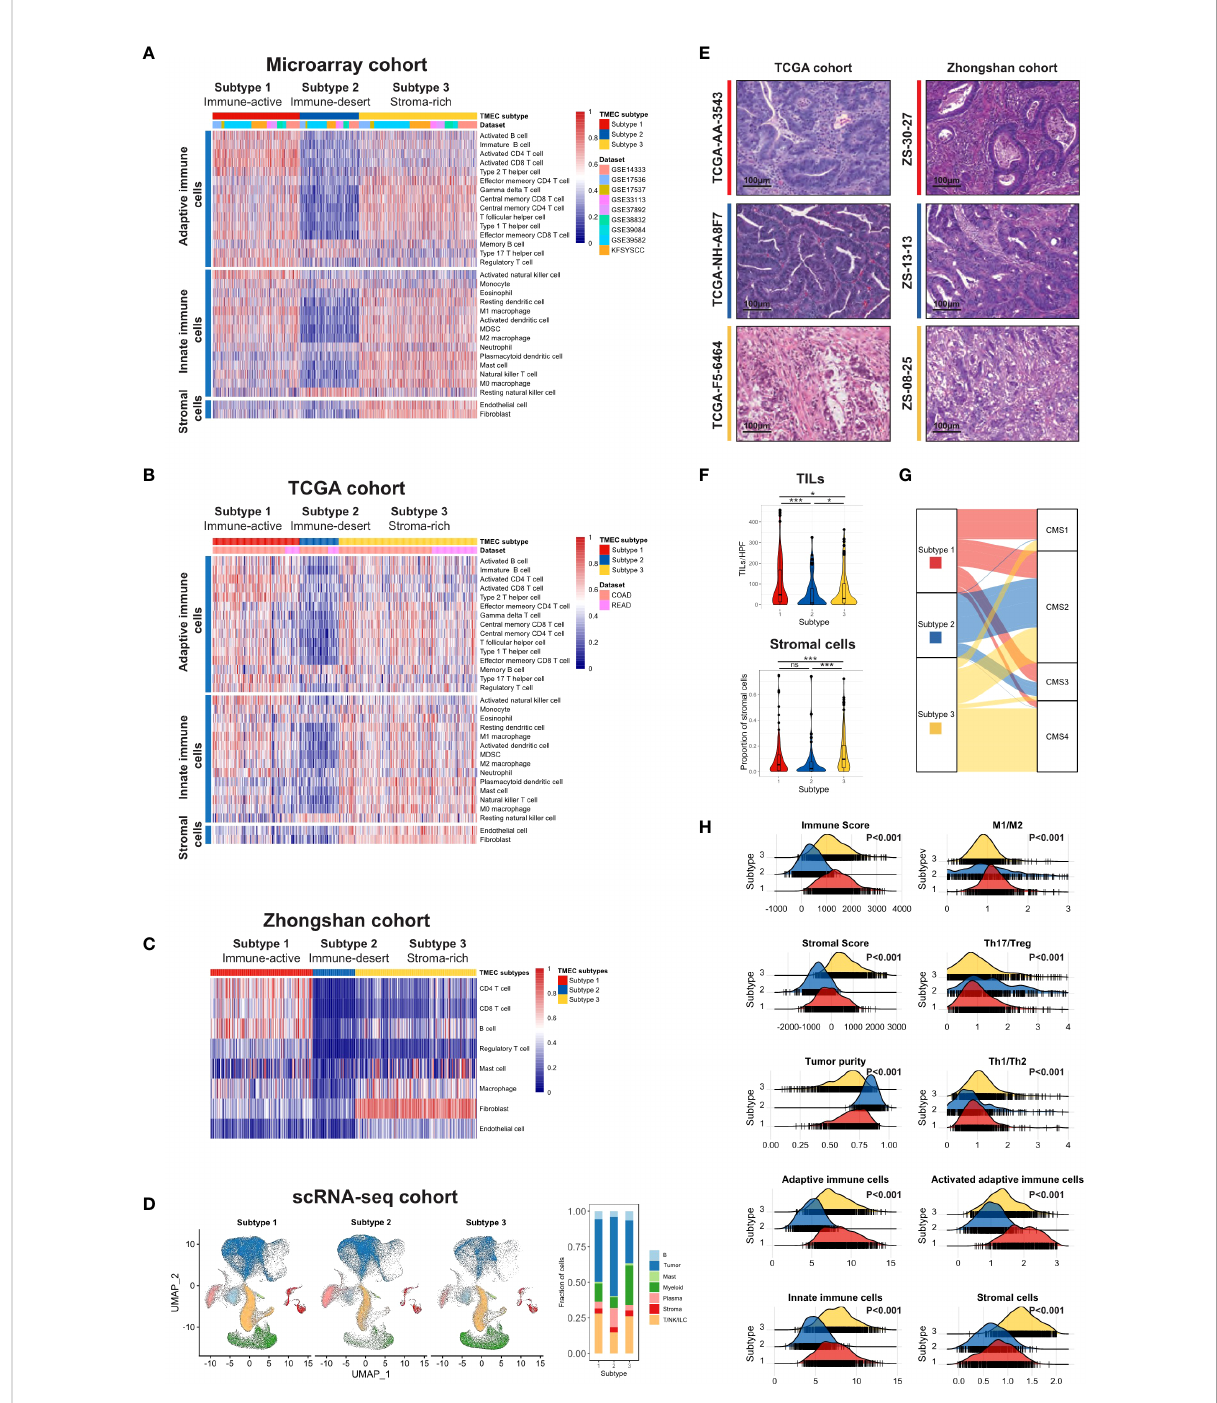
FIGURE 1 The landscape of TME cell in fi ltration pattern in CRC. (A, B) Heatmaps illustrating the in fi ltration of 31 TME cells in microarray (A) and TCGA (B) cohorts. Both were divided into three subtypes by unsupervised clustering. (C) Heatmap and clustering of major TME cells in fi ltration in Zhongshan cohort. (D) UMAP of all cells in the scRNA-seq cohort split by TMEC clusters (left) and the fraction of major cell types in three clusters (right). (E) The representative pathology presentation of each subtype in the TCGA (18) and Zhongshan cohort (red, subtype 1; blue, subtype 2; yellow, subtype3; from top to bottom). (F) The number of TILs (up) and proportion of stromal cells (down) among three subtypes per high power fi eld (HPF, 200x) in the TCGA cohort. (G) Sankey plot illustrating the distribution of CMS subtypes and TMEC subtypes in the microarray cohort. (H) The distribution of Immune Score, Stromal Score, tumor purity, macrophage M1/M2 ratio, Th17/Treg ratio, Th1/Th2 ratio, adaptive immune cells, activated adaptive immune cells, innate immune cells, and stromal cells among subtypes in the microarray cohort. *P < 0.05; ***P < 0.001; ns, P >